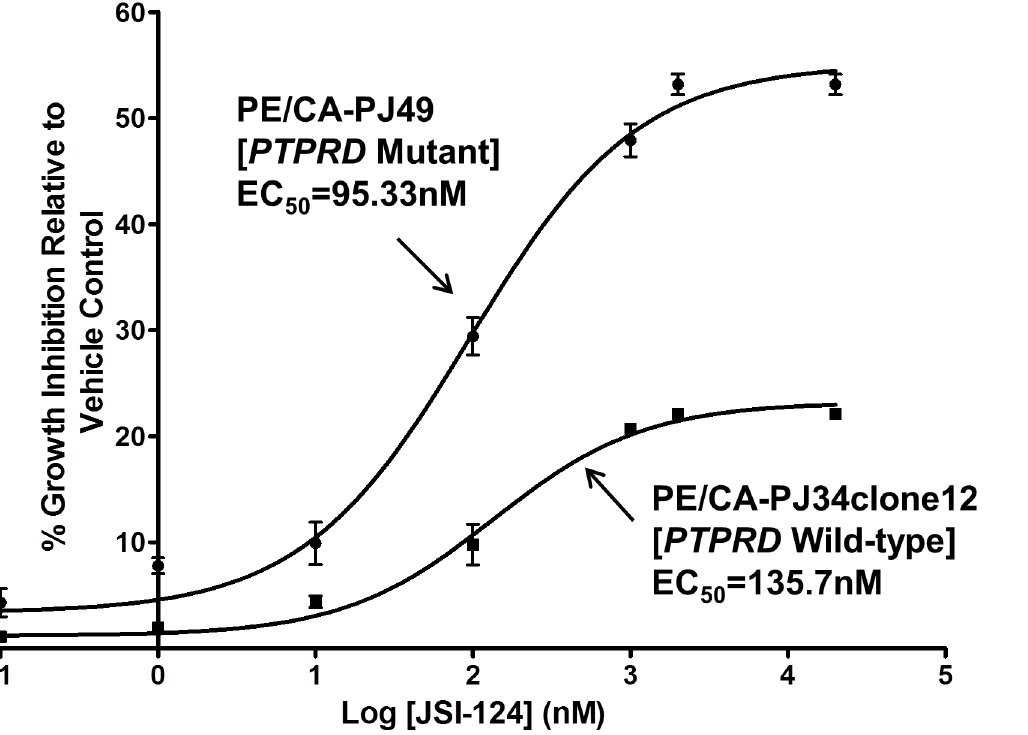
Fig 4. HNSCC cells harboring an endogenous PTPRD mutation (PE/CA-PJ49) are more sensitive to the STAT3 pathway inhibitor JSI-124 relative to representative PTPRD WT HNSCC cells (PE/CA-PJ34clone12). Cells were treated with increasing concentrations of JSI-124 for 24 hours followed by MTT assay. The experiment was performed three times with similar results.